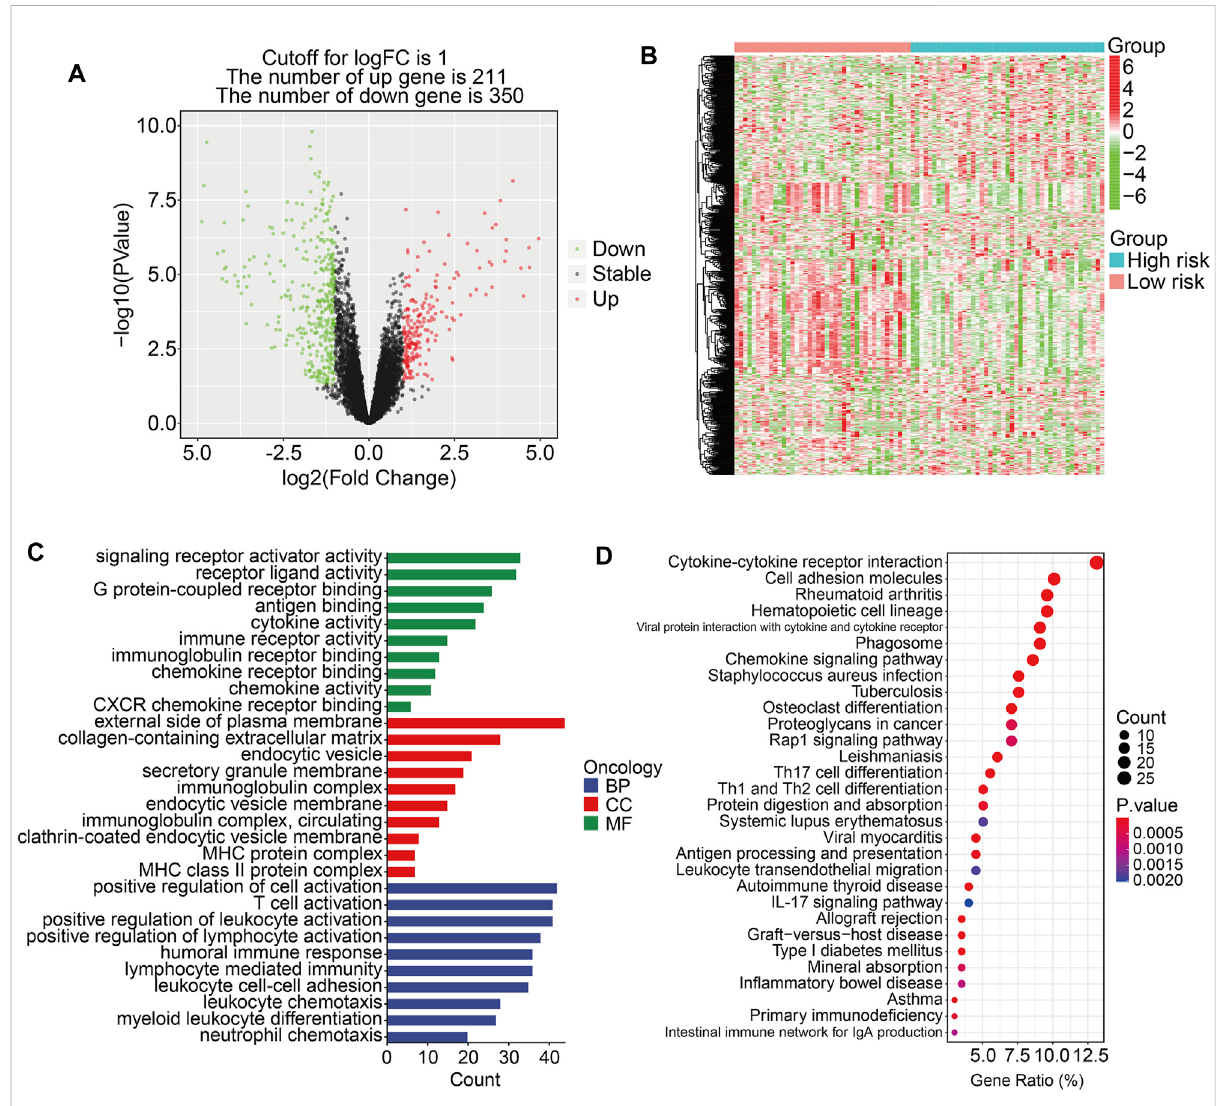
FIGURE 7 Identi fi cation of risk-related differentially expressed genes and functional enrichment analysis. (A) The volcano plot exhibits differentially expressed genes (DEGs) between the high- and low-risk groups. (B) Heatmap showing the expression pro fi les of the DEGs. (C – D) GO and Kyoto encyclopedia of genes and genomes enrichment analyses of the